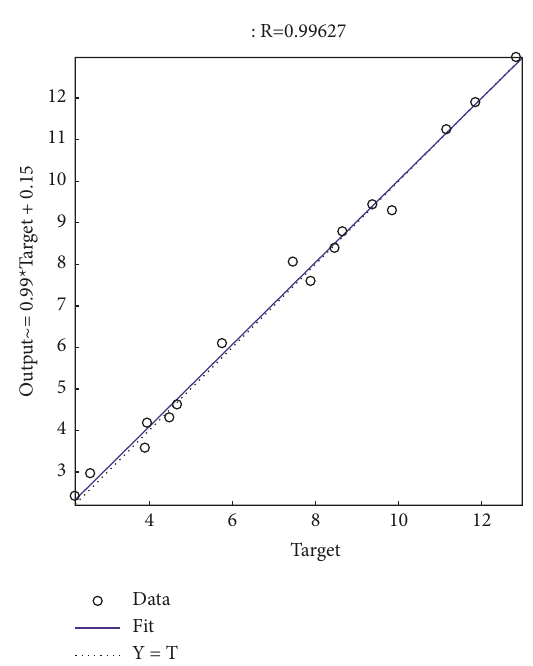
Figure 23: The regression plot of the ANN